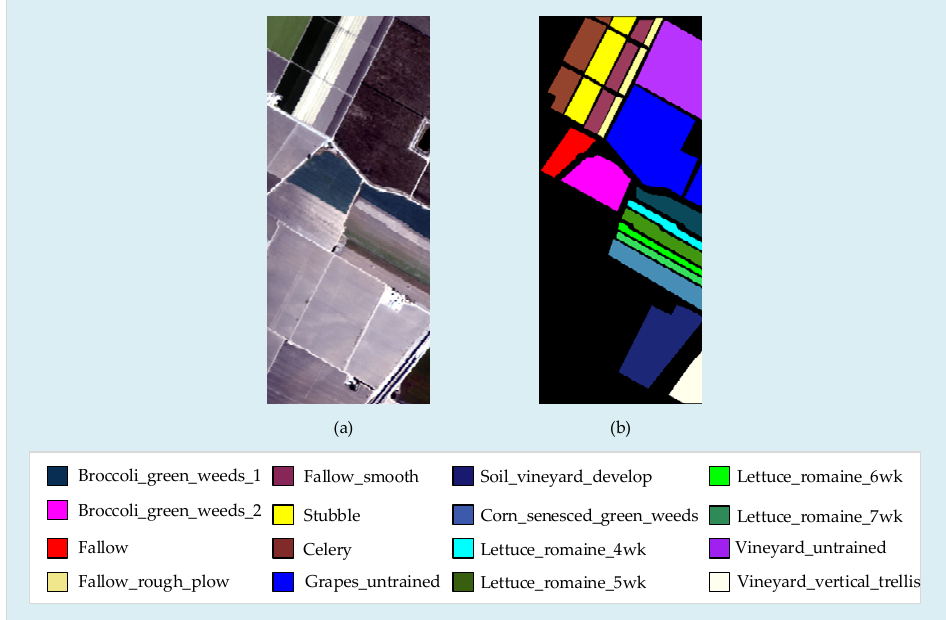
Figure 2. ( a ) The pseudo-colour image of Salinas; ( b ) ground truth classification map of Salinas.